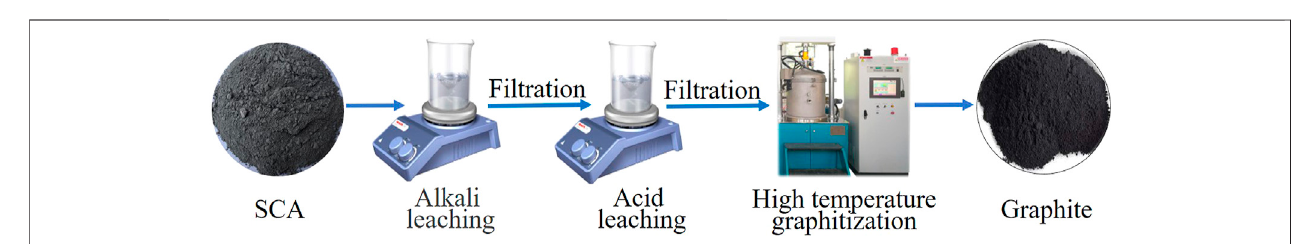
FIGURE 10 | SCA treatment via alkali – acid leaching combined with high temperature graphitization.